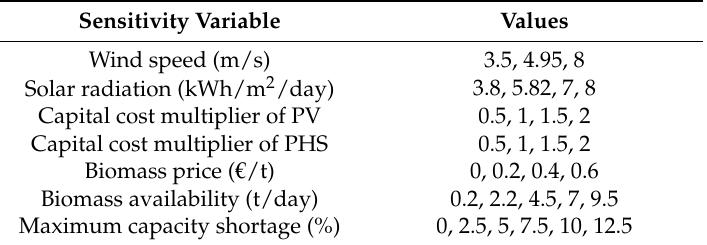
Table 9. Sensitivity variables and associated